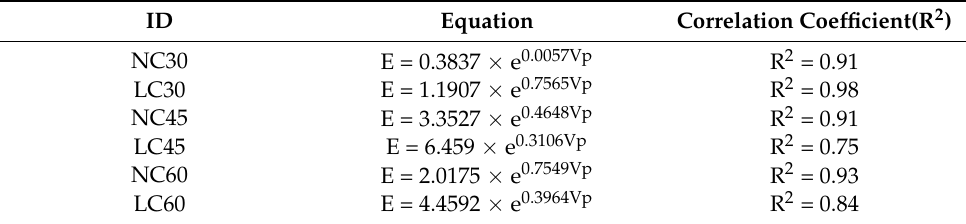
Table 8. Correlation between the elastic modulus and the ultrasonic pulse velocity.